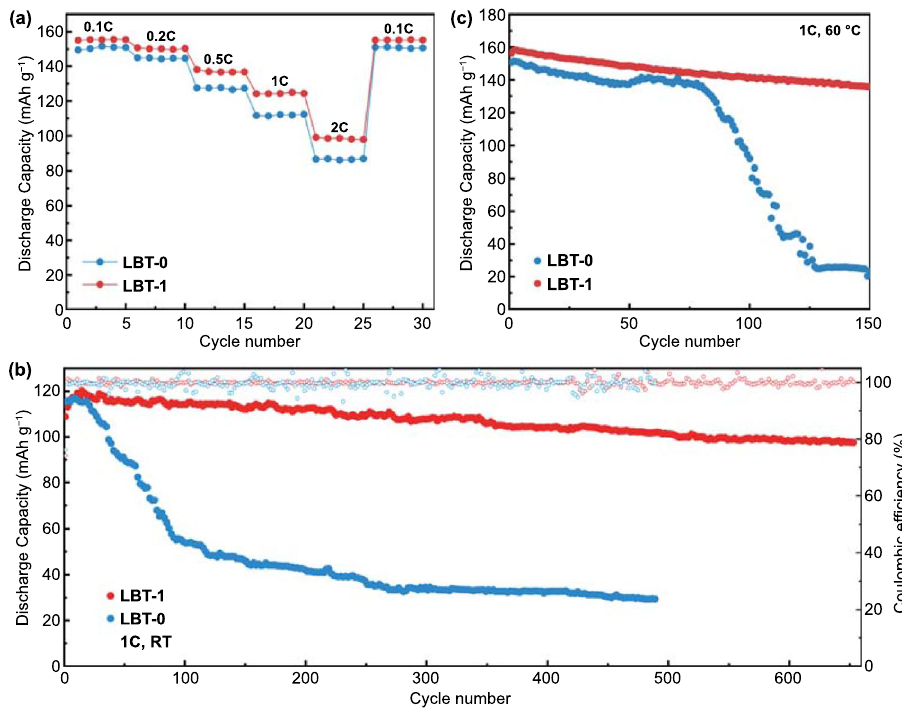
Fig. 6 Performance of Li||LFP cell with different electrolytes: a rate performance at room temperature, b cycle performance at 1 C and room temperature and c cycle performance at 1 C and 60